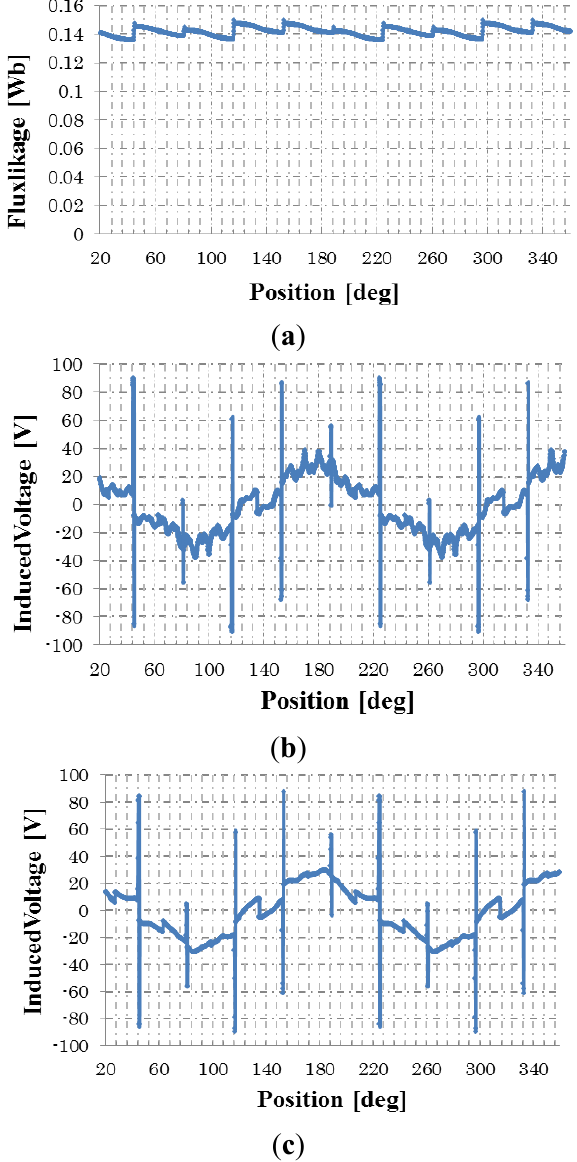
Figure 9. No-load induced voltage under half-wave rectified excitation with triangular wave modulation. ( a ) Flux linkage; ( b ) induced voltage; ( c ) induced voltage for skewed